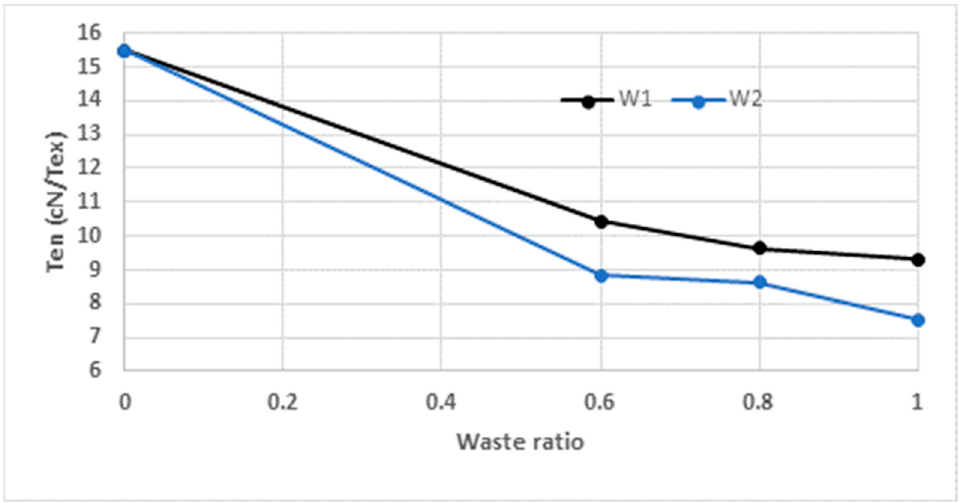
Figure 4. The effect of the proportion of waste fibre content on the tenacity of blended yarns. 88.5 Figure 5. The effect of the proportion of waste fibre content on the elongation of blended yarns. The results confirm that, globally, the quality of blended yarns using W1 waste is better than the quality of those using W2 waste. The quality of the yarns correlates to the quality of the fibres created. The data demonstrate that W2 waste fibres are more stressed than W1 waste fibres with better quality. It is interesting to note the variation in quality between the yarns, with both types being suitable for a waste fibre content of up to 60%. When analysed, the irregularity (Cvm (%)) of W1-blended yarns increases by 16.7% when the proportion of waste fibres used ranges from 0% to 60%. It increases by approx- imately 53% when the proportion of waste fibres used ranges from 60% to 80%. For W1- and W2-blended yarns, it can be confirmed that a maximum of 60% of waste fibres can be used in the blend, as when this proportion is exceeded, a significant increase in yarn ir- regularity occurs. For the mechanical properties of yarns, with W1-fibre-blended yarns, the tenacity of the yarn decreases by 32% when 0% to 60% waste fibres are used, and there is a decrease in elongation of 15%. This degradation becomes less critical when the waste fibre content is between 60% and 80%. 4 4.555.566.57 7.5